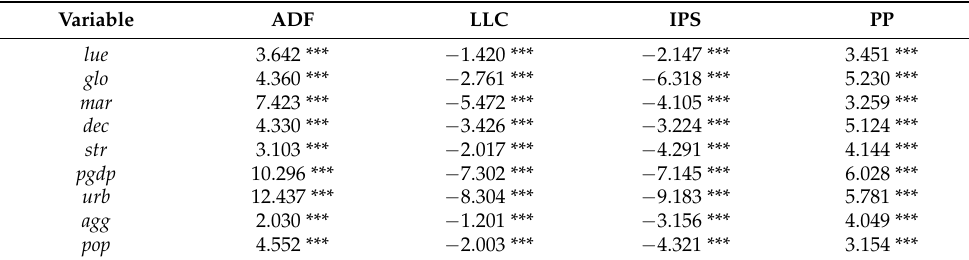
Table 4. Stability test results of panel data.